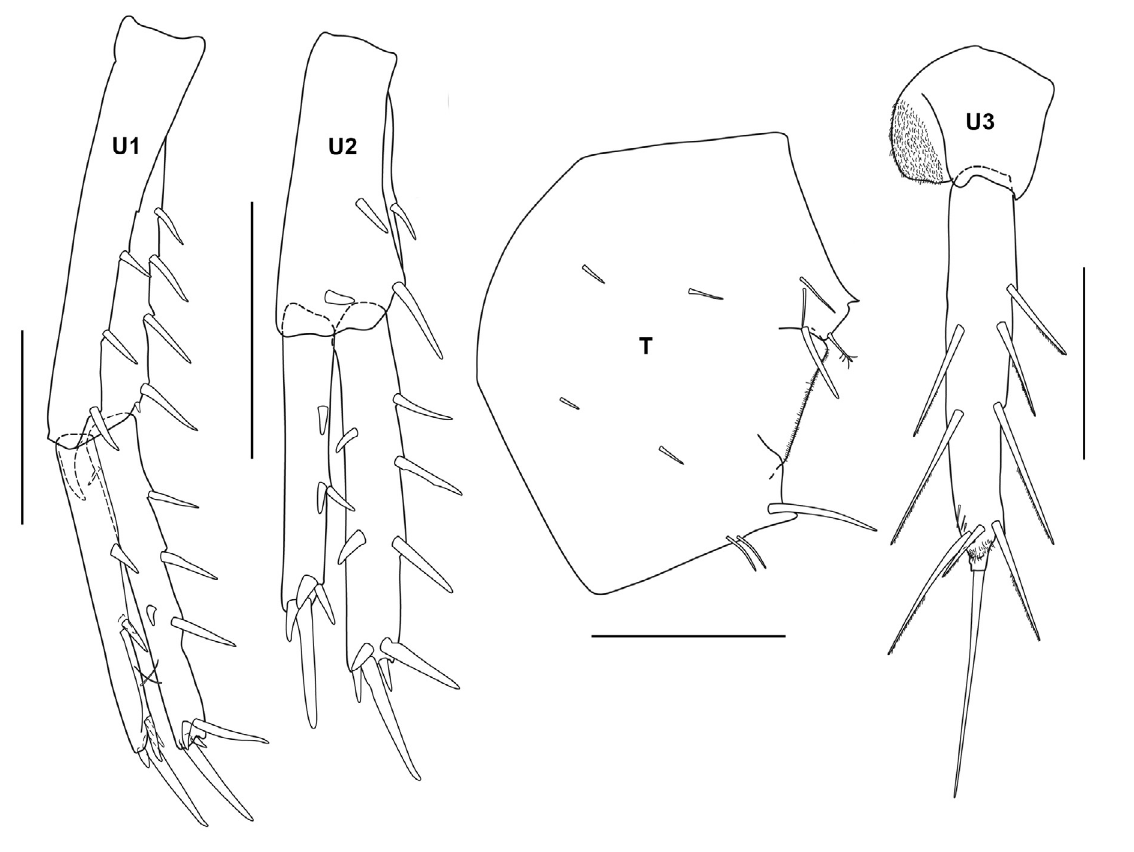
Fig. 6. Grandidierella pawaiensis sp. nov., holotype, ♂ (ZRC 2018.0493). Scale bars: U3 = 0.1 mm; remaining scales = 0.2